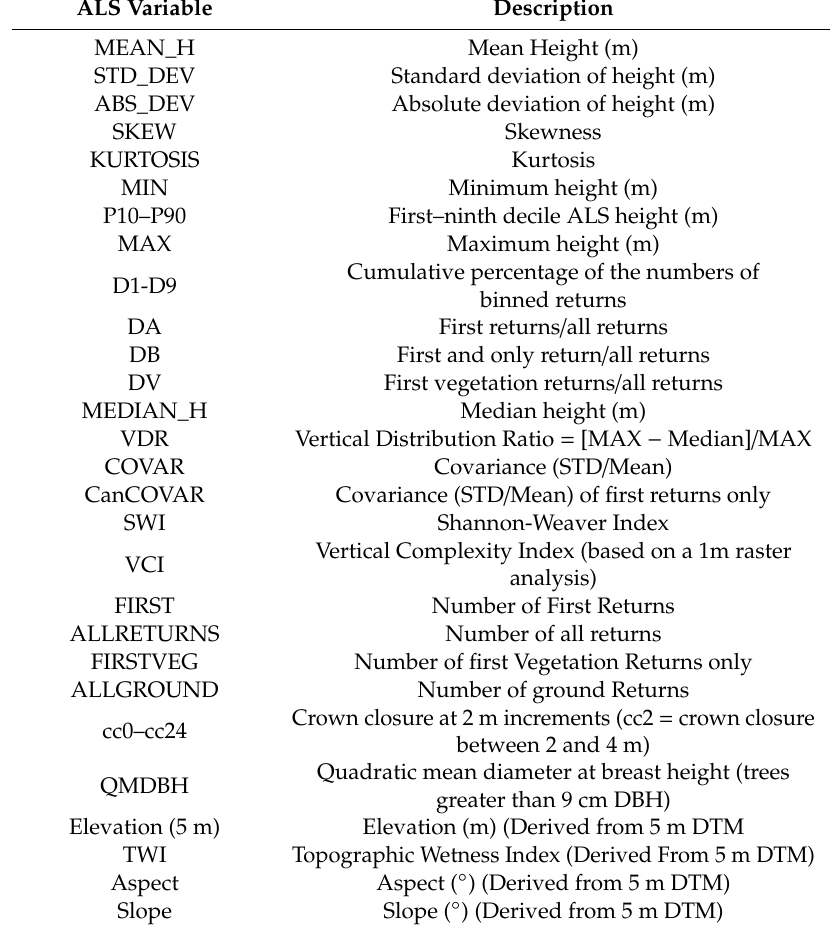
Table 1. Complete list and description of predictor variables derived from ALS point cloud from which a smaller subset was selected for fitting final